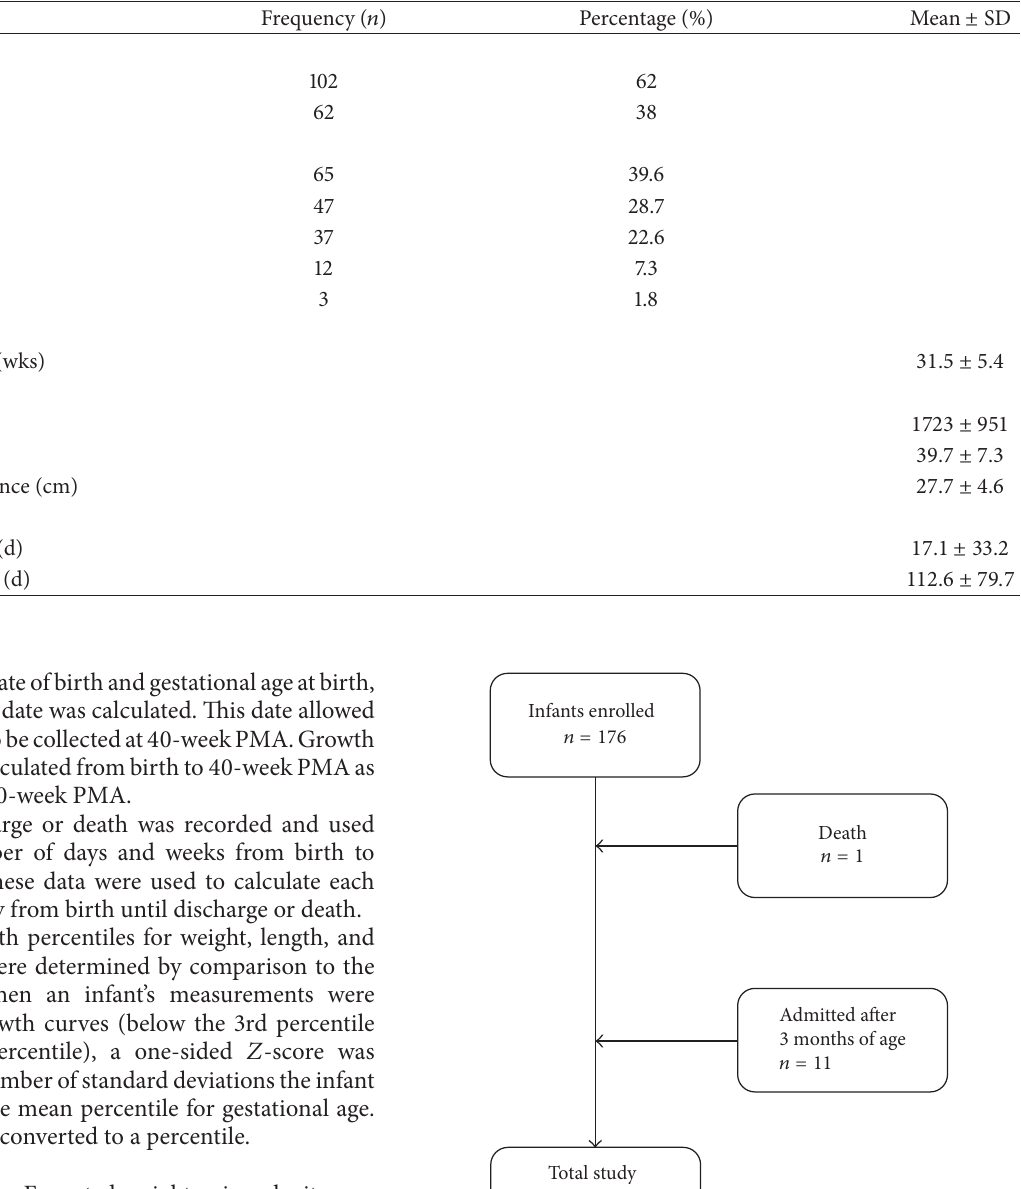
Table 1: Demographic characteristics of NICU infants with intestinal failure or feeding intolerance ( 𝑁 = 164 ).